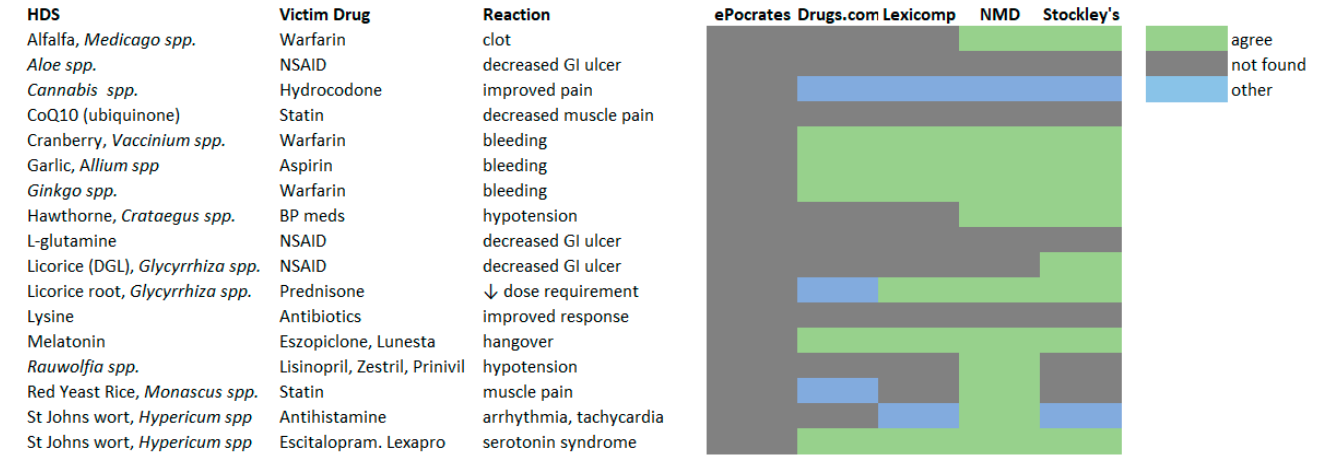
Figure 4. Agreement between HDI checking resources and respondent reports. Agree—HDI resource-matched herb–drug or drug class pair and reaction; not found—no herb–drug reaction found for the pair; other—an unrelated reaction found for the pair. BP blood pressure, NSAID non-steroidal anti-inflammatory drug NMD Natural Medicines Database